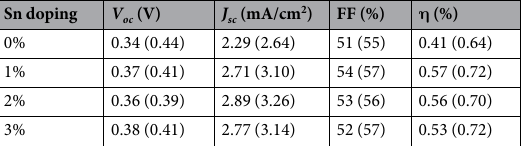
excess solvent. All processes were performed under ambient condition. Finally, 130 nm Ag was deposited on the films through a shadow mask by thermal evaporation under a vacuum pressure of < 5 × 10 − 6 mbar. Characterization. The surface morphology and structural properties of nanowires were characterized using